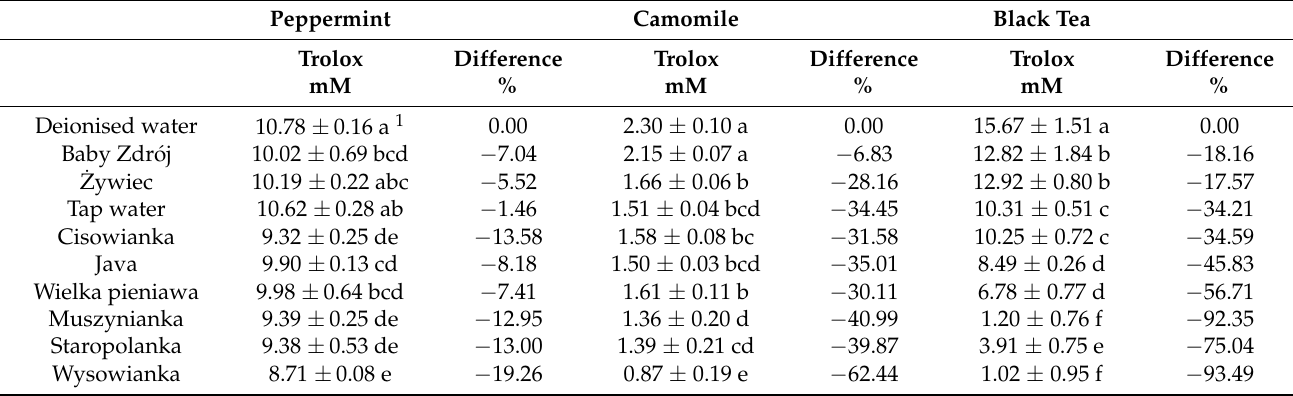
Table 2. Percentage decrease of antioxidant activity (converted to mM of Trolox) of peppermint, chamomile and black tea brews prepared with the use of mineral waters relative to the brew prepared with the use of deionized water.